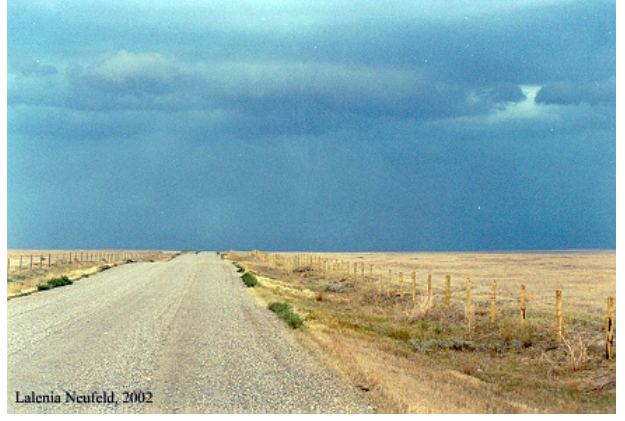
Fig. 1 . Example of a road/fenced edge in our study area, southern Alberta, Canada. Photo credit: Lalenia Neufeld,